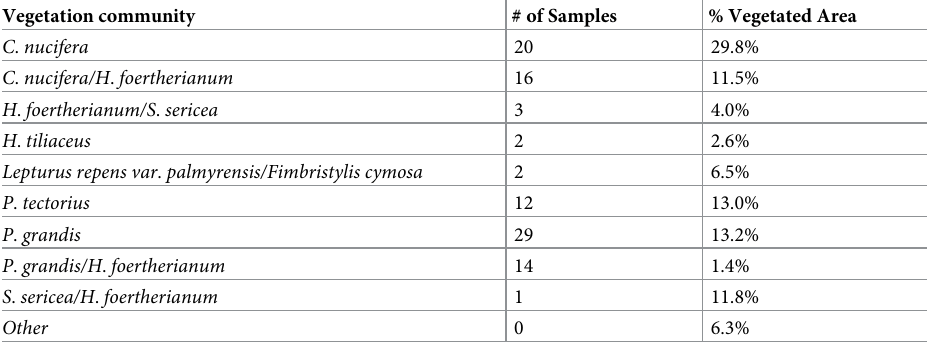
Number of soil samples by vegetation community, and proportional representation of each community type across Palmyra’s vegetated